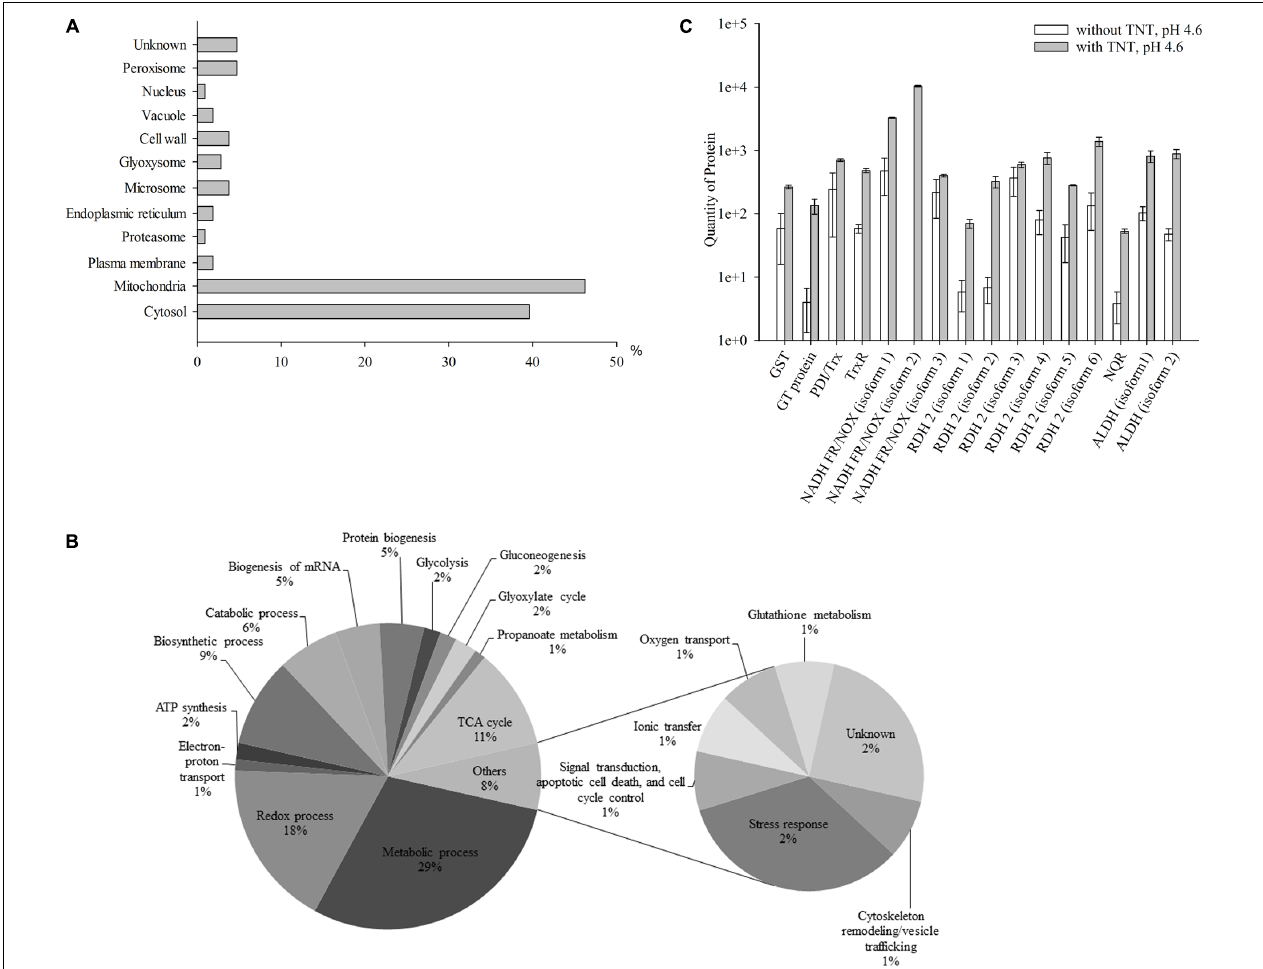
FIGURE 2 | Up-regulated proteins at the second stage of TNT transformation by Y. lipolytica : their intracellular localization (A) ; participation in metabolic processes (B) and the quantity of major proteins maximal up-regulated by TNT transformation products. (A,B) For 100% all identified proteins at the second stage of TNT transformation were taken. (C) Error bars represent the standard deviation of duplicate biological experiments with two technical repetitions. GST, glutathione S -transferase; GT, glutathione transferase protein; PDI/Trx, protein disulfide isomerase/thioredoxin; TrxR, thioredoxin reductase; NADH FR/NOX, NADH flavin oxidoreductases/NADH oxidases; RDH, retinal dehydrogenase 2; NQR, NADPH:quinone oxidoreductase; ALDH, aldehyde